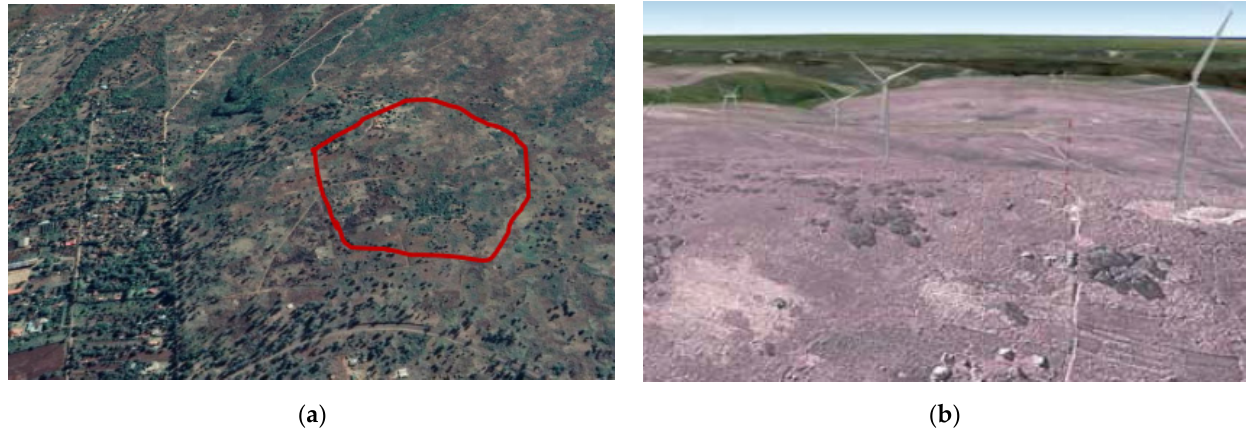
Figure 2. ( a ) Proposed site for Namaacha wind farm. Courtesy of Google Earth, land for wind farm allocation (25°58 ′ 19 ′′ S, 32°01 ′ 56 ′′ E, elevation 497M); ( b ) Overview of the wind farm’s landscape. Courtesy of FUNAE